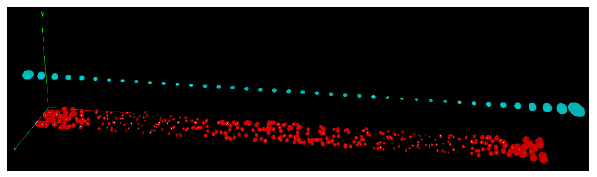
Figure 2. Error ellipsoids for 40